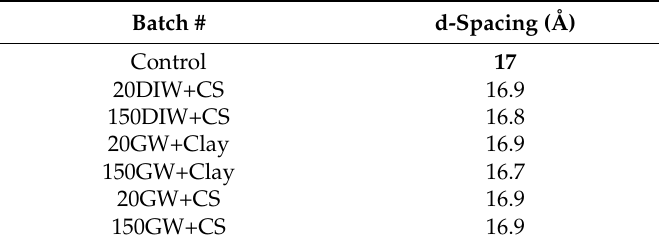
Table 6. d-Spacing of the glycolated clay